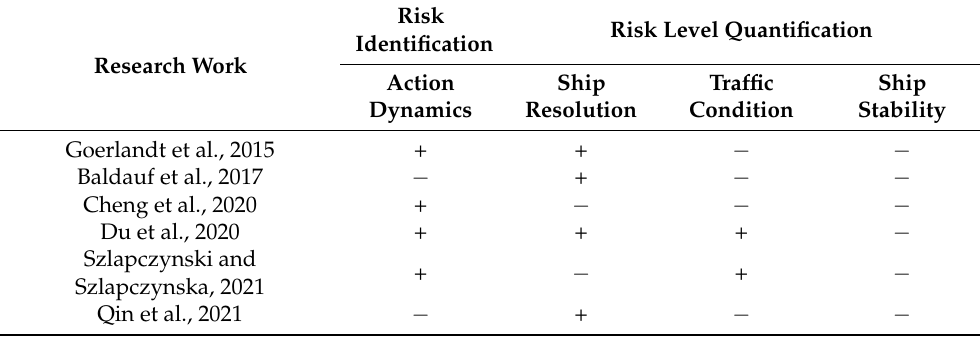
Table 1. Several typical works related to CAS published in recent